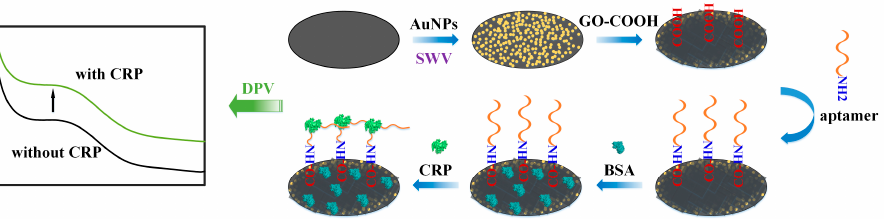
Figure 1. Illustration of the manufacturing process of the label-free C-reactive protein (CRP) ap- tamer